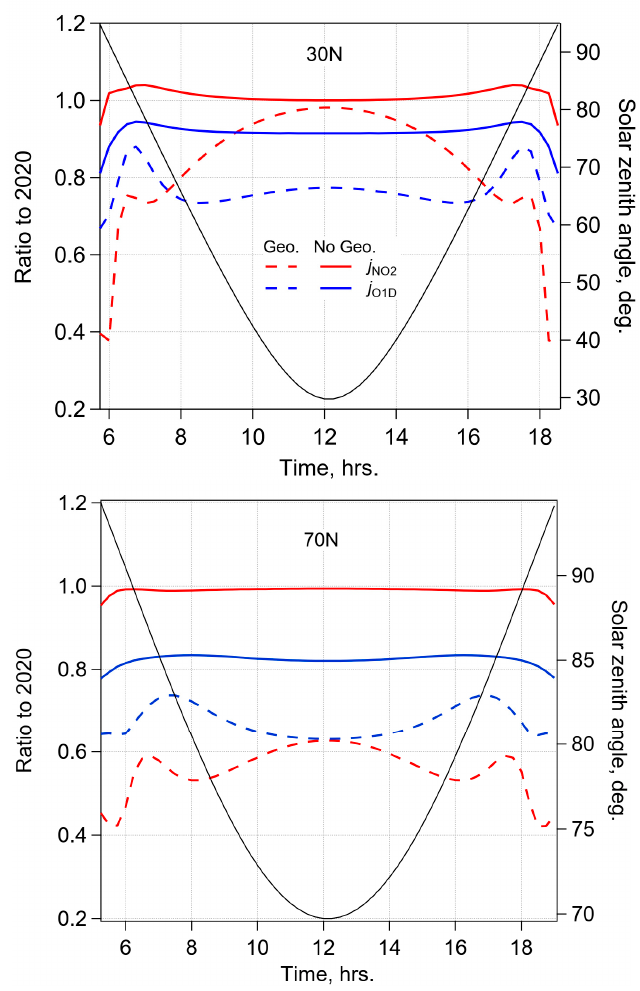
Figure 6. Changes for key tropospheric photolysis coefficients, for the reactions NO 2 + h ν → NO + O ( j NO2 , red) and O 3 + h ν → O 2 + O( 1 D) ( j O1D , blue), for March 2080 relative to current day (March 2020), without geoengineering (solid curves) and with geoengineering (dashed curve). The black curve and right axis refer to solar zenith angle.